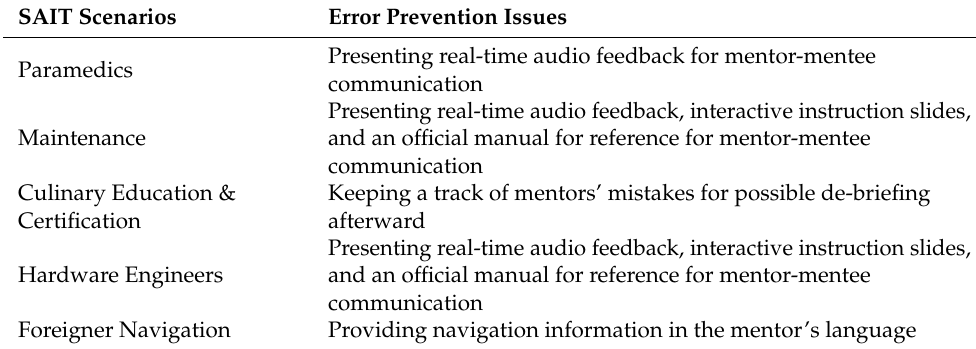
Table 10. Error prevention issues in SAIT